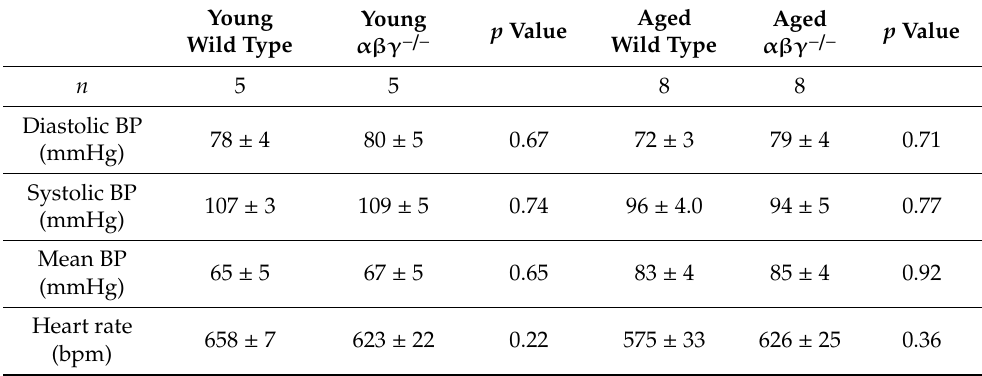
Table 4. Hemodynamic parameters measured under urethane anesthesia (1.2 g kg − 1 , i.v.) in αβγ − / − and wild-type control animals for both young and aged groups. Means ± S.E.M were compared with Mann–Whitney U rank